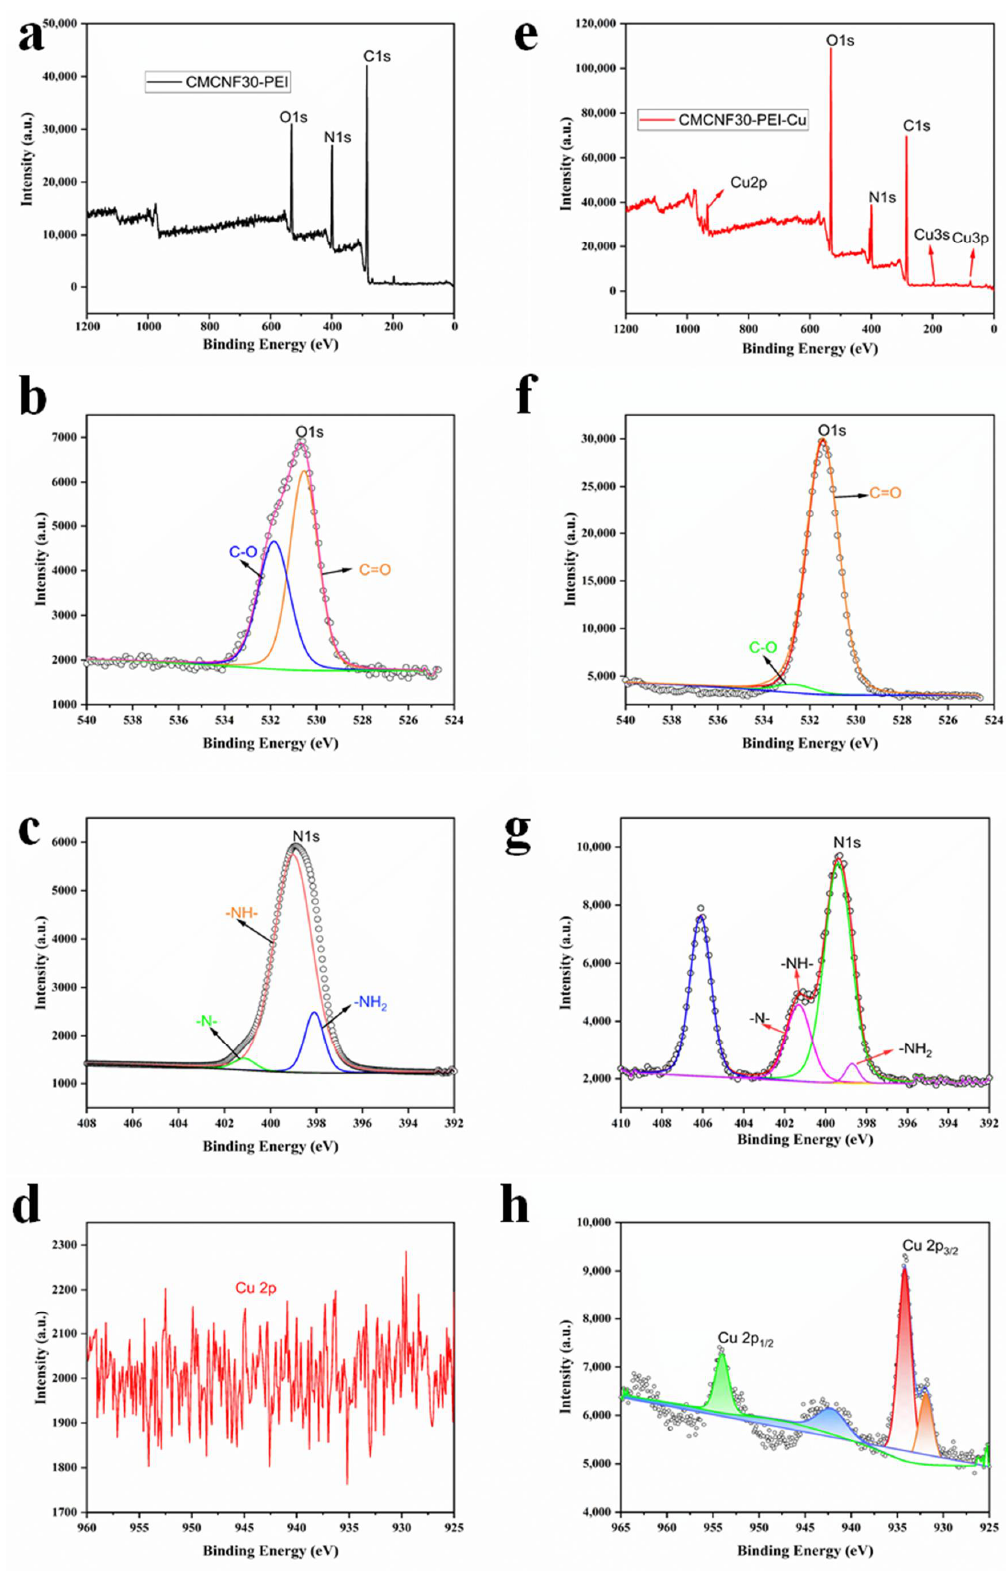
Figure 6. ( a ) Wide-scan XPS spectrum and ( b – d ) high-resolution core-level spectrum of CMCNF30- PEI, ( e ) wide-scan XPS spectrum and ( f – h ) high-resolution core-level spectrum of CMCNF30-PEI after Cu 2+